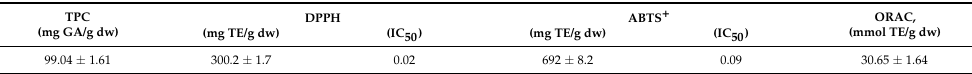
Table 1. Antioxidant characteristics of sweet grass extract.